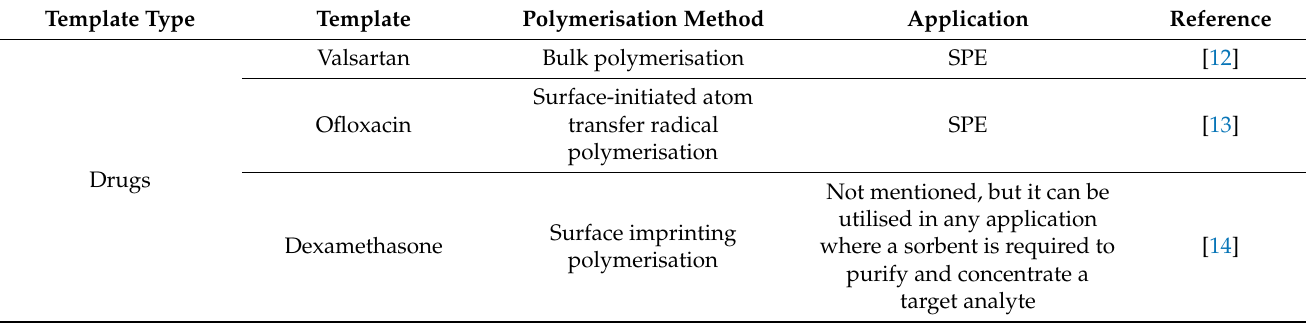
Table 1. Single templates used for molecularly imprinted polymers